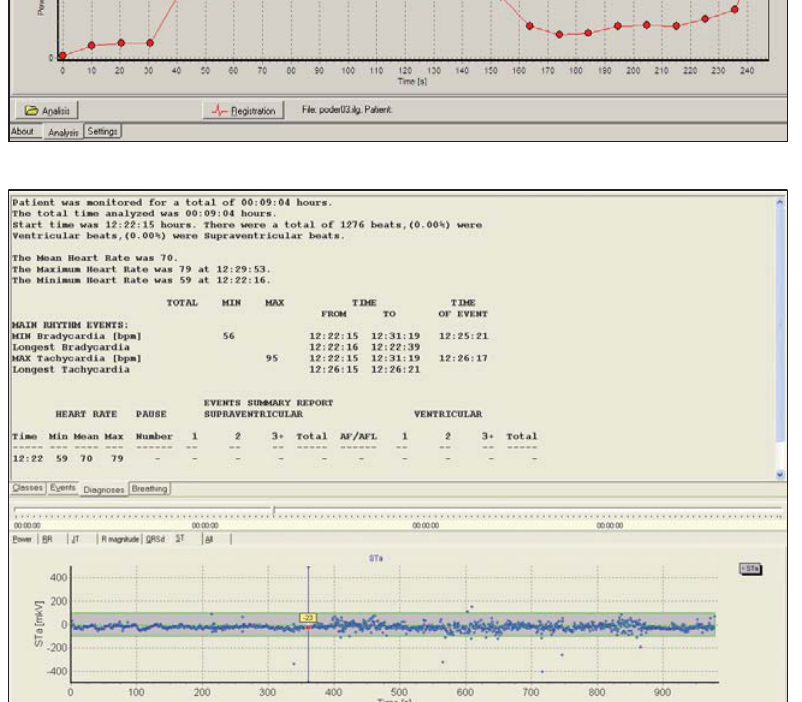
Figure7. Results of evaluation of athlete’s activity, developing power (W)